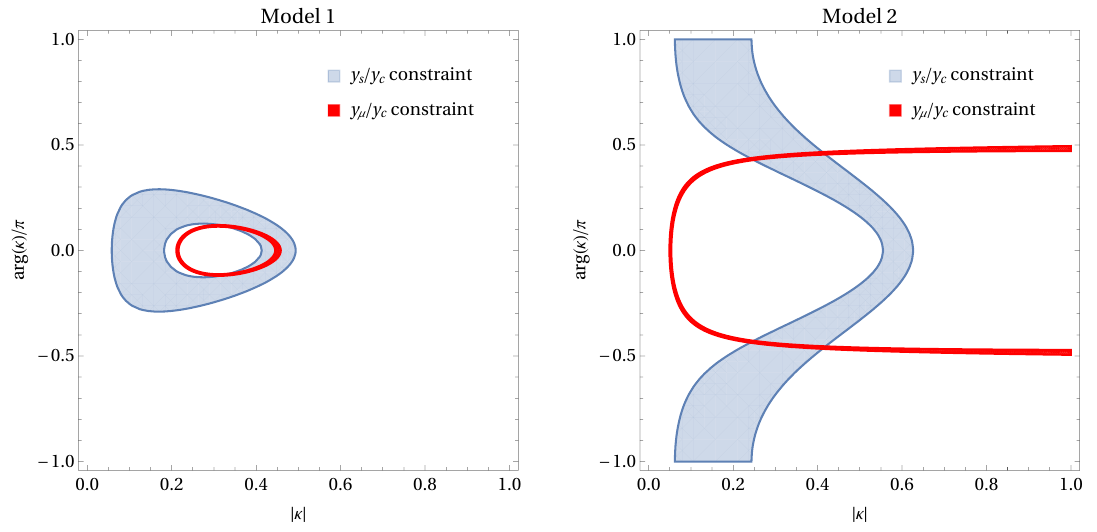
Figure 5 . Allowed regions of the 2nd family ratios y s =y c (blue) and y (cid:22) =y c (red) in the modulus- phase plane for the complex (cid:20) for model 1 (left) and model 2 (right) of Example 2. Notice that overlap regions exist in both